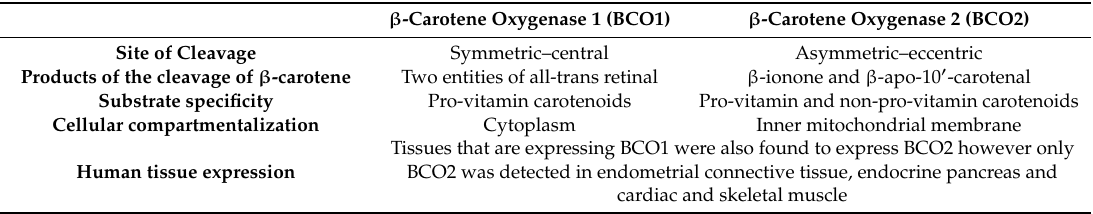
Table 2. β -carotene oxygenase 1 (BCO1) and β -carotene oxygenase 2 (BCO2) enzymes have di ff erent site and products of β -carotene cleavage, substrate specificity, cellular compartmentalization and human tissue